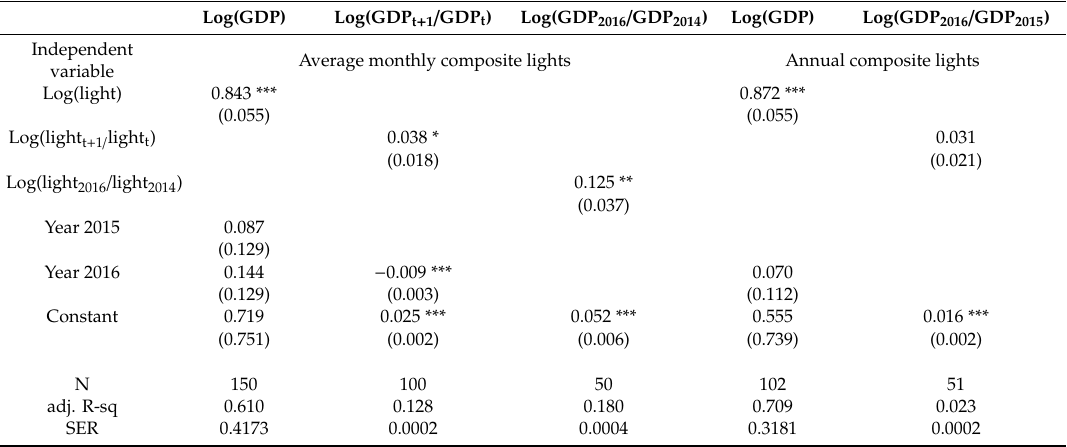
Table 1. Robust regression results for state annual and growth data.